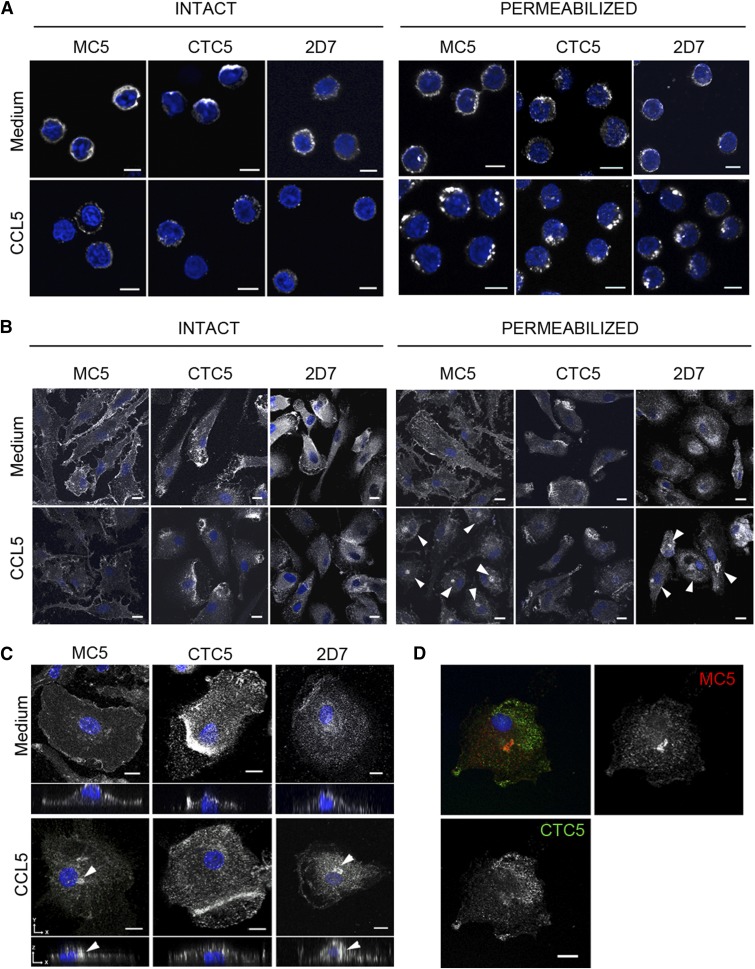
Distribution and CCL5-mediated internalization of CCR5 on human blood cells. T-cell blasts (A) and MDMs (B–D) were incubated in medium alone or with CCL5 (100 nM) for 1 h at 37°C before samples were stained with MC5, 2D7, or CTC5, as indicated. (A–B) cells were fixed and stained intact or permeabilized to visualize cell surface or total receptors, respectively. Individual panels show representative single-confocal sections depicting fields of views for T cell blasts or MDMs; arrowheads highlight the perinuclear accumulation of CCR5 in MDMs (B). (C) XY maximum-intensity projections with a XZ cross-section view reconstituted from Z-stack confocal images of permeabilized MDMs. (D) A representative maximum-intensity projection image of permeabilized, CCL5-treated MDMs costained with MC5 (red) and CTC5 (green); all samples were DAPI stained (blue). Scale bars, 5 µm (A) and 10 µm (B–D).